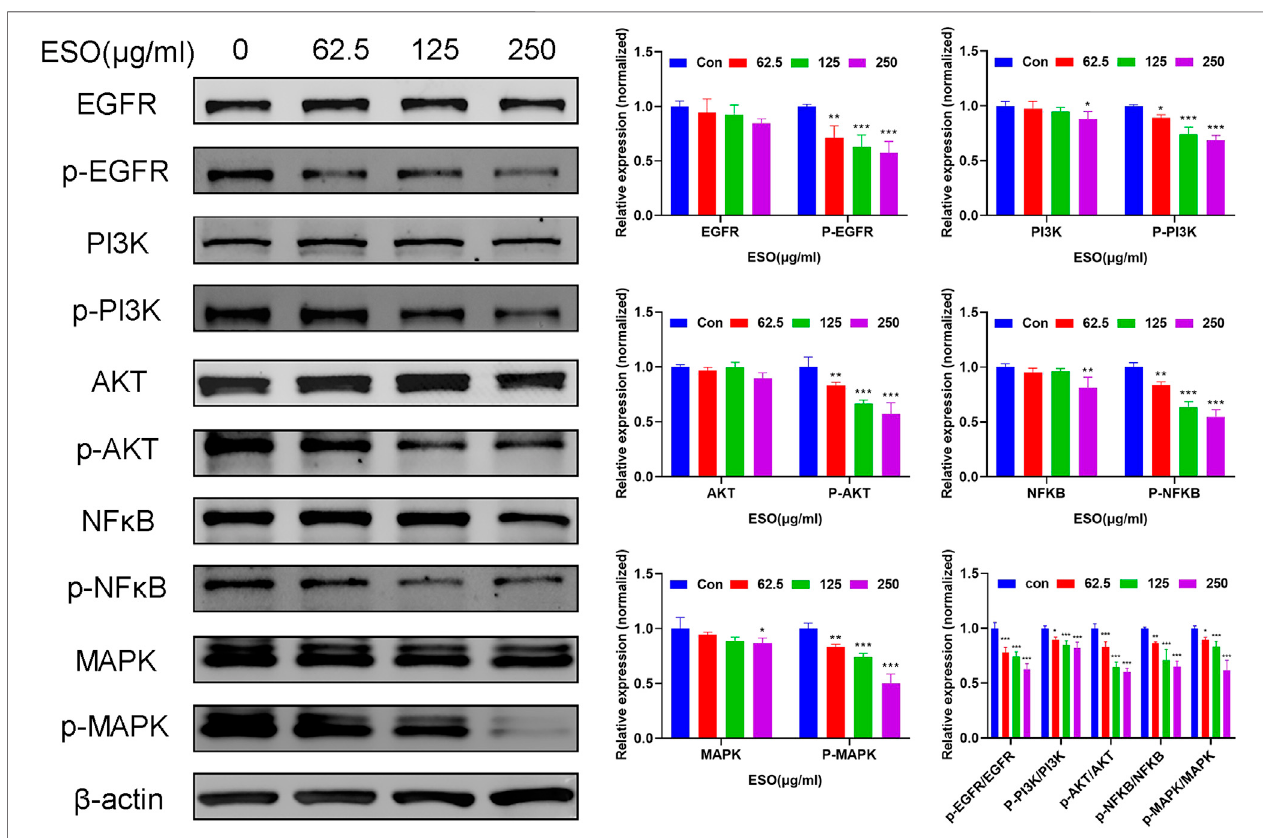
FIGURE9| WesternblotanalysisofrelatedproteinswithESOtreatmentinHepG2cells* p < 0.05,** p < 0.01,*** p < 0.001vs.thecontrolgroup.Statisticalresultsof protein levels ware normalized by control group.